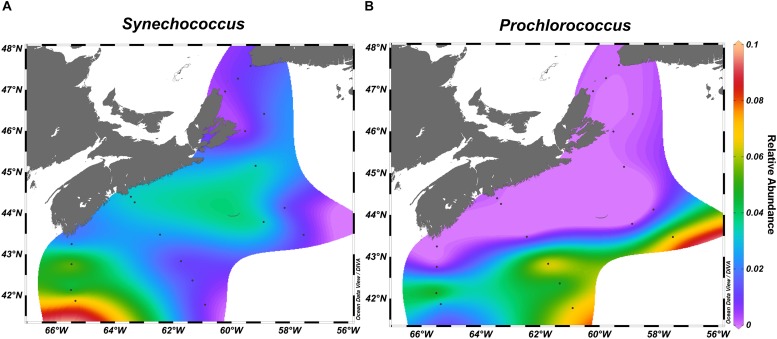
Synechococcus
(A) and Prochlorococcus
(B) relative abundance across the surface of the Scotian Shelf in fall.